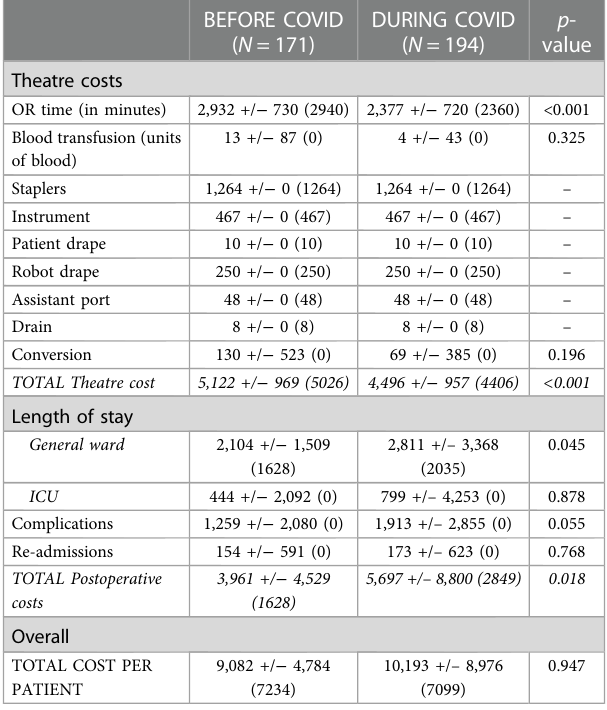
TABLE 7 Demographics of patients undergoing RATS lung resection before and during the COVID-19 pandemic.